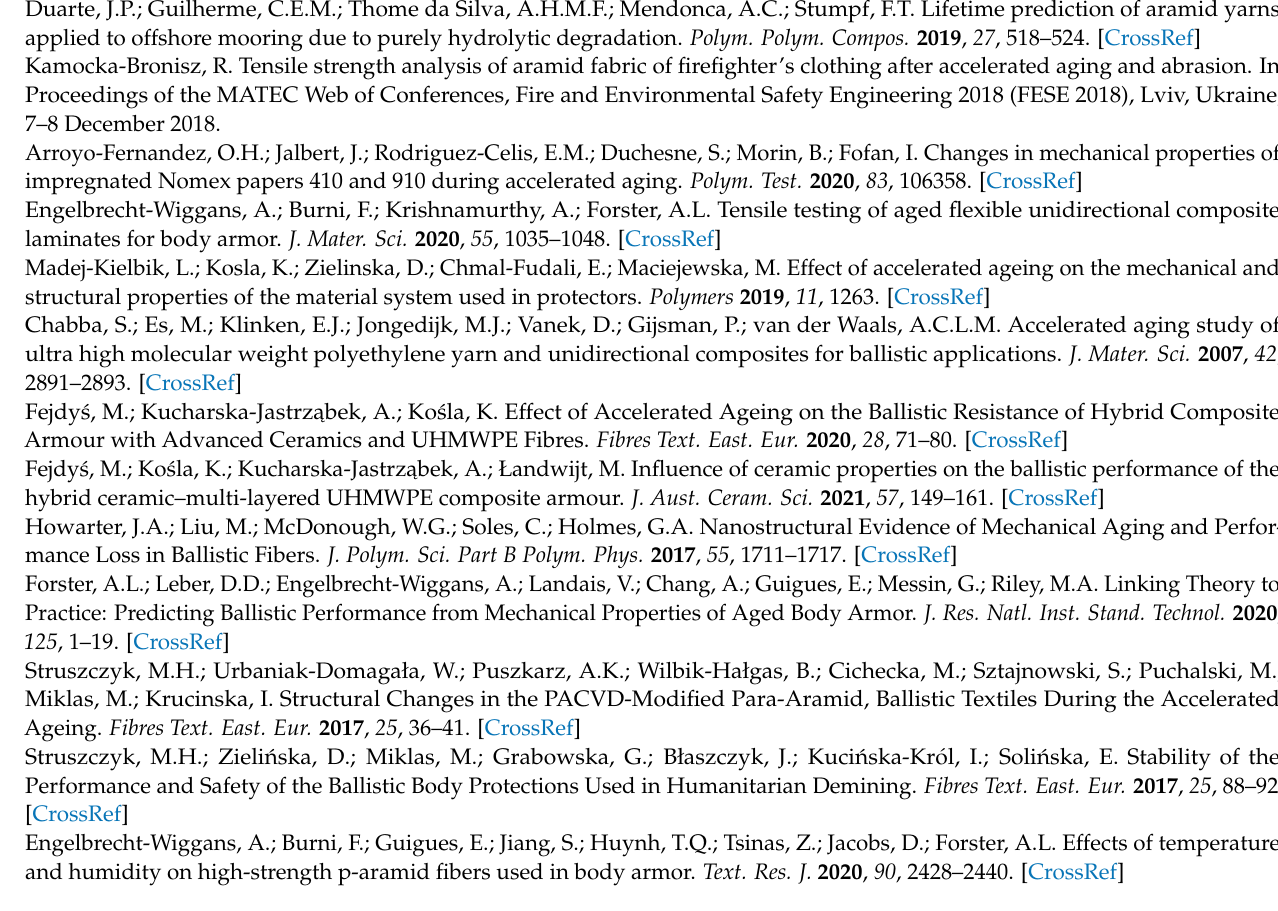
Table S2: 5% and 50% temperature-induced mass loss of sample A and B (TG analysis performed in air atmosphere); Figure S2: Thermogravimetric curves of sample A and B obtained in air